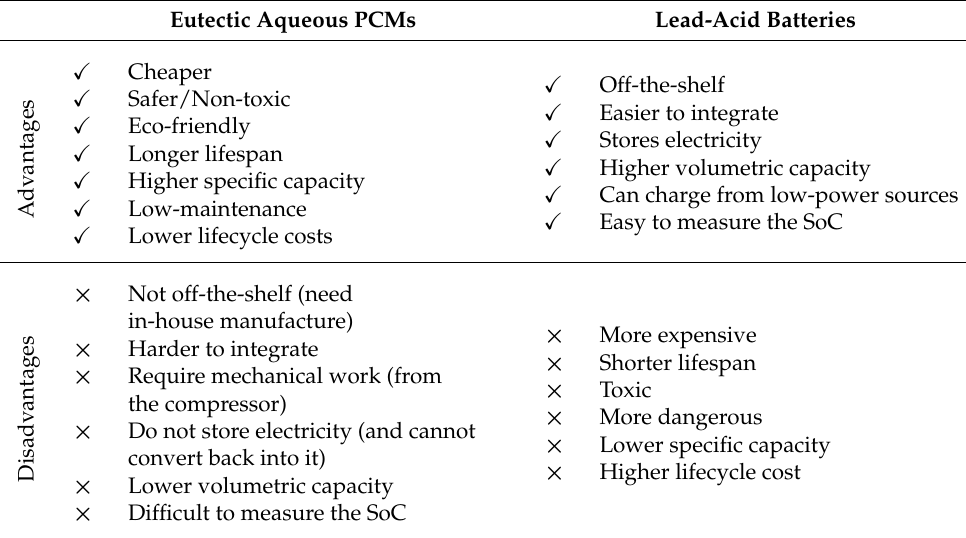
Table 3. Advantages and disadvantages of eutectic aqueous PCMs versus lead-acid batteries, for the current application [57].